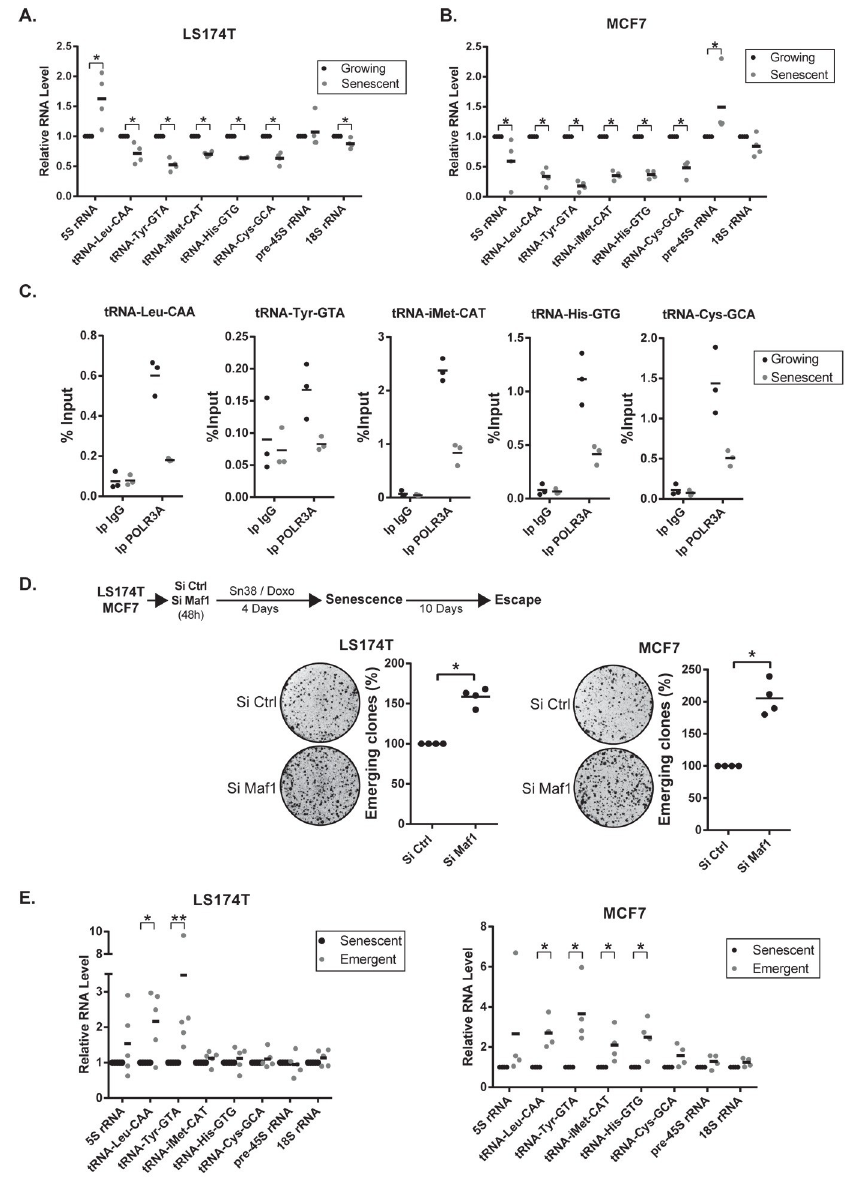
Fig 4. Regulation of tRNA synthesis during senescence and CIS escape. A, B. Expression of the indicated RNAs in growing or senescent cells (LS174T n = 4, MCF7 n = 4, Kolmogorov-Smirnov test, � = p < 0.05). C. ChIP analysis of the binding of the type III RNA polymerase (POLR3A) in senescent or growing LS174T cells (n = 3). D. LS174T and MCF7 were transfected with a control siRNA or a siRNA directed against Maf1 48h prior to chemotherapeutic treatment. After senescence induction, cells were washed with PBS and stimulated with fresh media. Ten days later, the number of emerging clones was analyzed (n = 4, Kolmogorov-Smirnov test, � = p < 0.05). E. Analysis of the expression of the indicated RNAs in senescent or emergent cells (after 7 days, LS174T n = 5, MCF7, n = 4, Kolmogorov-Smirnov test, � = p < 0.05, �� = p < 0.01). and senescent cells. RT-QPCR results indicated that tRNA expression was down-regulated in senescent cells, both in LS174T and MCF7 cells (Fig 4A and 4B). In contrast, the expression of the 18S and pre-45S ribosomal RNAs was not significantly modified, further indicating that the activity of RNA pol I was not affected under these experimental conditions. Surprisingly,